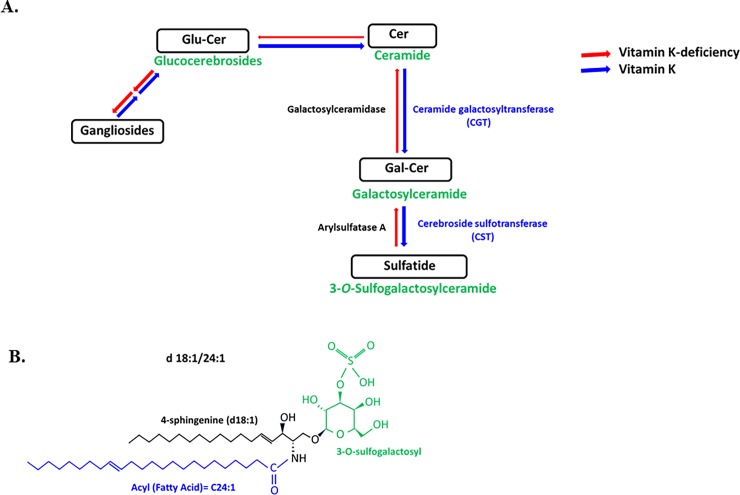
A. A schematic diagram showing the synthesis of sulfatides from ceramide, and how the production of sulfatides during remyelination may be affected by a vitamin K-deficiency. B. The structure of d18:1/C24:1 sulfatide, which is a major myelin sulfatide. Vitamin K increases the synthesis of this sulfatide, among other sulfatides, after 3 weeks of remyelination. This sulfatide is composed of a ceramide moiety containing 4-sphingenine (d18:1) with a C24:1 fatty acid.